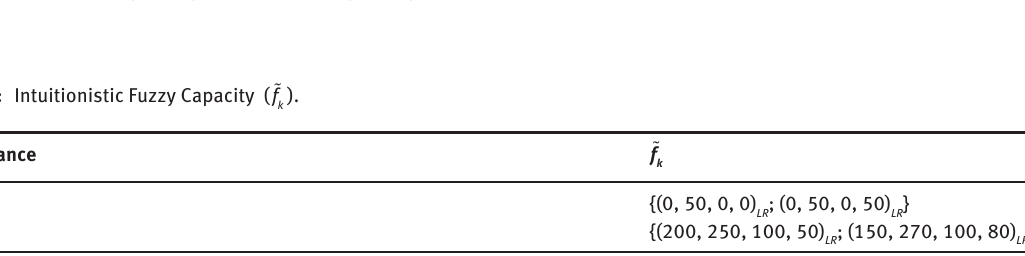
Table 6: Intuitionistic Fuzzy Capacity ( ).